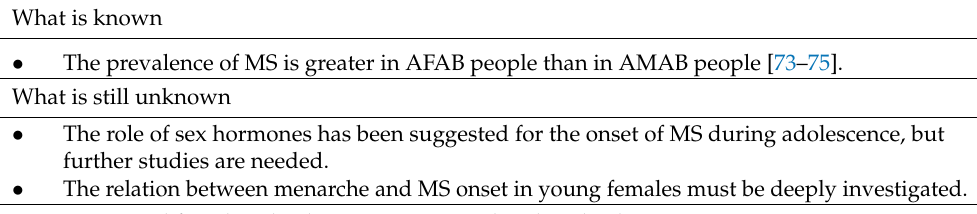
Table 4. Available evidence on the relationship between multiple sclerosis (MS) and gender.